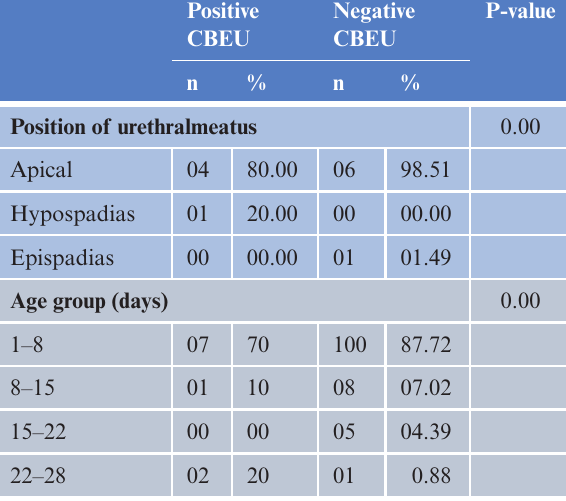
Table 4: Factors associated with the onset of urine tract infection in newborns at the Departmental Teaching Hospital of Borgou-Alibori (DTH-B/A) in